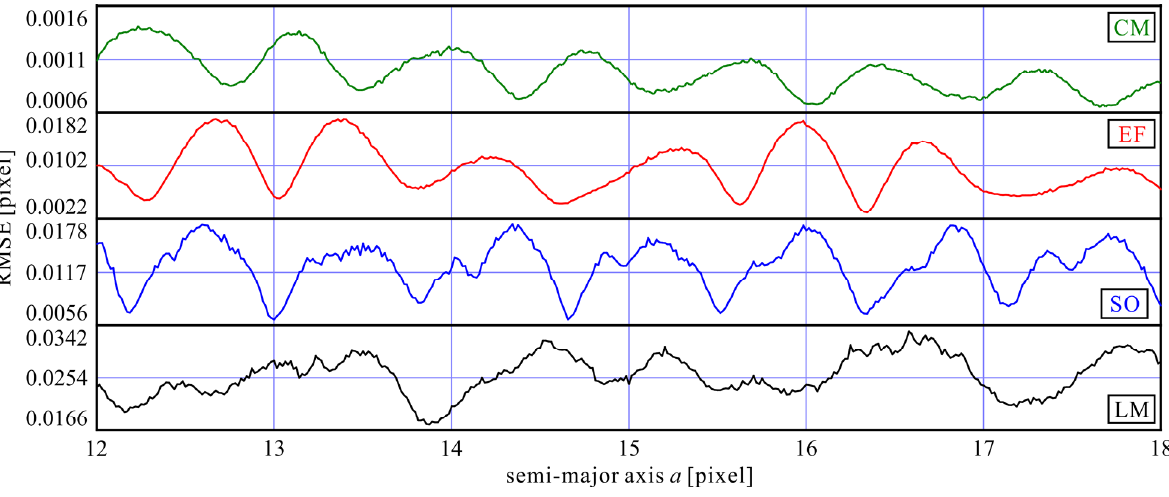
Figure 8. RMSE of the center location measurement of an ellipse (12 pixels  a  18 pixels, f = 0.50, 